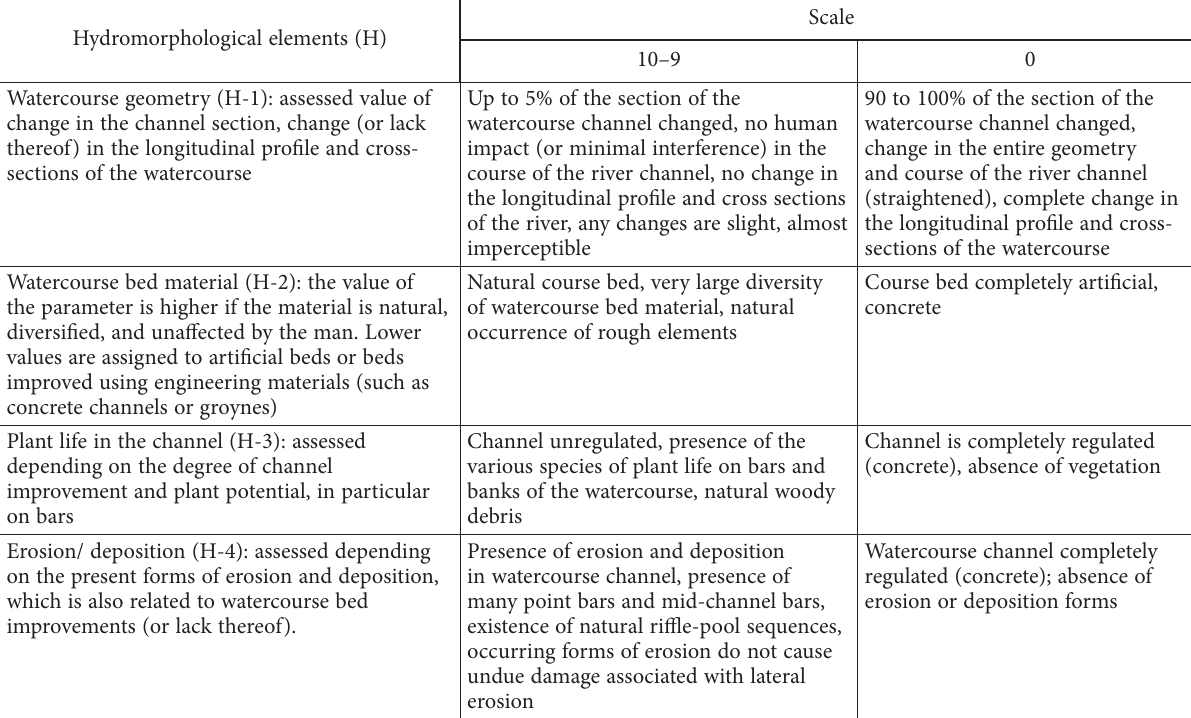
Table 1. Extreme values of hydromorphological elements as per the LSHM Method (source: author’s study)